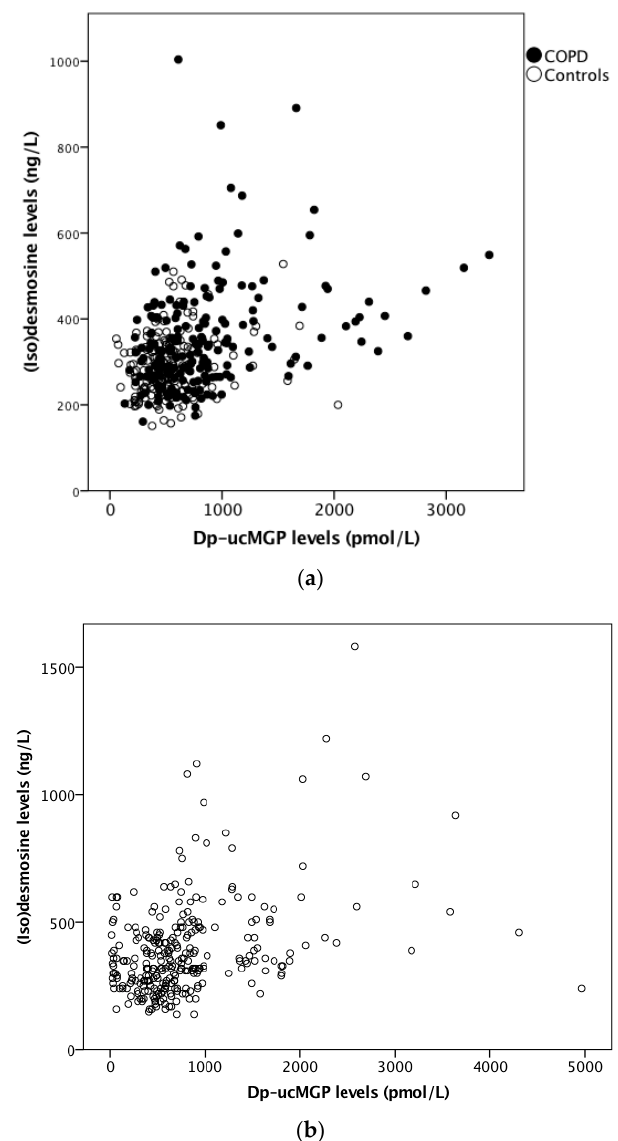
Figure 3. Scatterplots showing ( a ) the significant positive association between plasma inactive Matrix Gla Protein (MGP) levels and plasma desmosine levels in COPD patients (black circles) and controls (white circles) from the ICE-Age cohort, and ( b ) the association between plasma inactive MGP levels and plasma desmosine levels in COPD patients in the Leuven cohort.